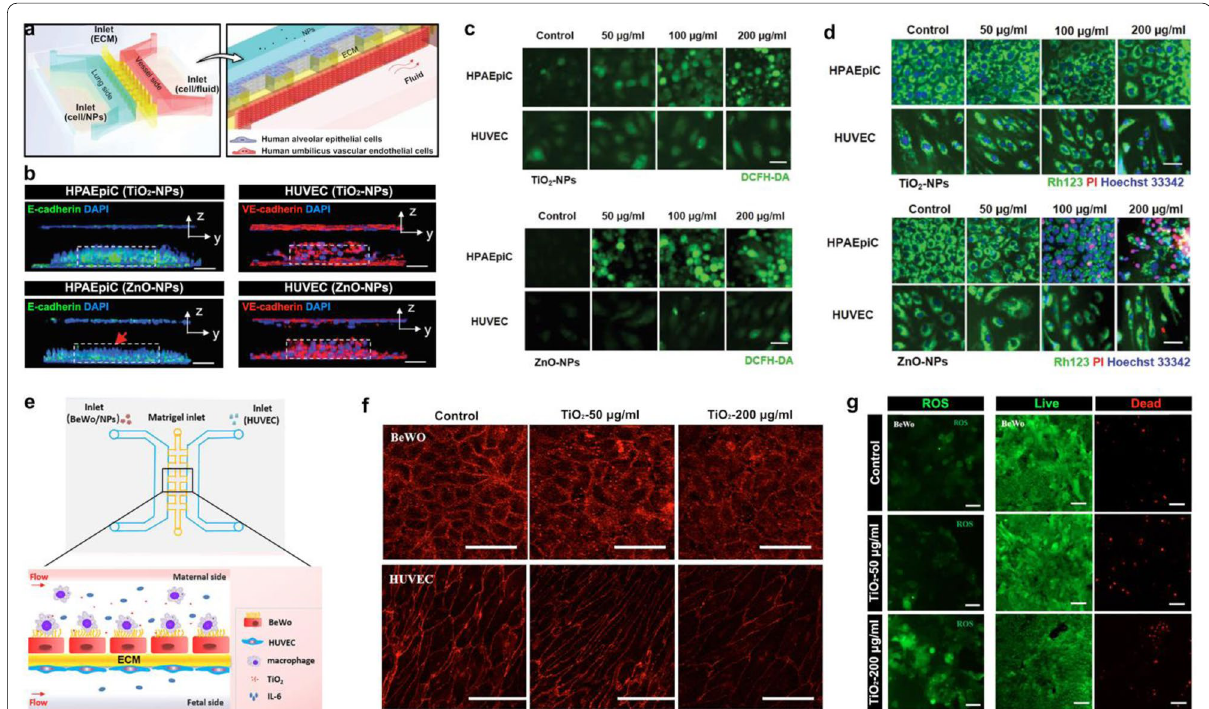
Fig. 5 Toxicity of ZnO and TiO 2 nanoparticles. a A lung-on-a-chip model was created by culturing human pulmonary alveolar epithelial cells (HPAEpiC) and human umbilical vein endothelial cells (HUVEC), separated by a Matrigel ECM. b Introduction of TiO 2 nanoparticles did not affect epithelial or endothelial barrers, but ZnO nanoparticles created a noticeable disturbance in the epithelial barrier (red arrow). Scale bars, 100 µm. c The reactive oxygen species (ROS) generation and d the cellular apoptosis of both nanoparticles was assessed to determine their cytotoxic effects. TiO 2 nanoparticles induced ROS production in epithelial cells but had no effect on apoptosis. ZnO nanoparticles induced both epithelial and endothelial ROS production and resulted in a dose-dependent increase in epithelial apoptosis. Scale bars, 50 µm. e A similar placental barrier-on-a-chip was created using BeWo human trophoblast cells and HUVECs. f When TiO 2 nanoparticles were flown across the device, the placental barrier integrity was compromised. Scale bars, 100 µm. g High TiO 2 concentrations resulted in significant ROS generation and BeWo cell apoptosis. Scale bars, 50 µm (left), 100 µm (middle,